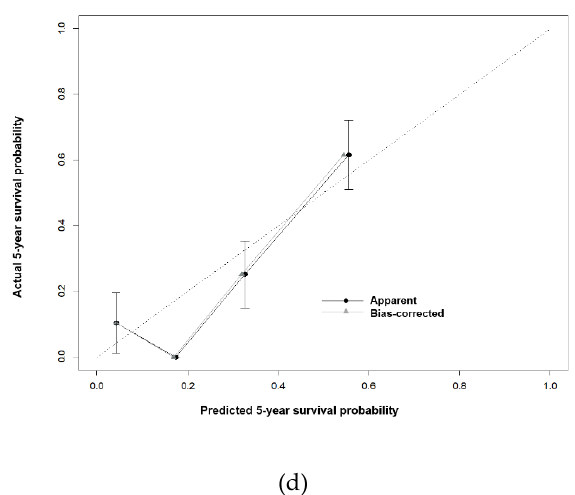
Figure 3. Calibration plots comparing predicted and actual one- and five-year ( a , b ) disease-free survival and ( c , d ) overall survival.